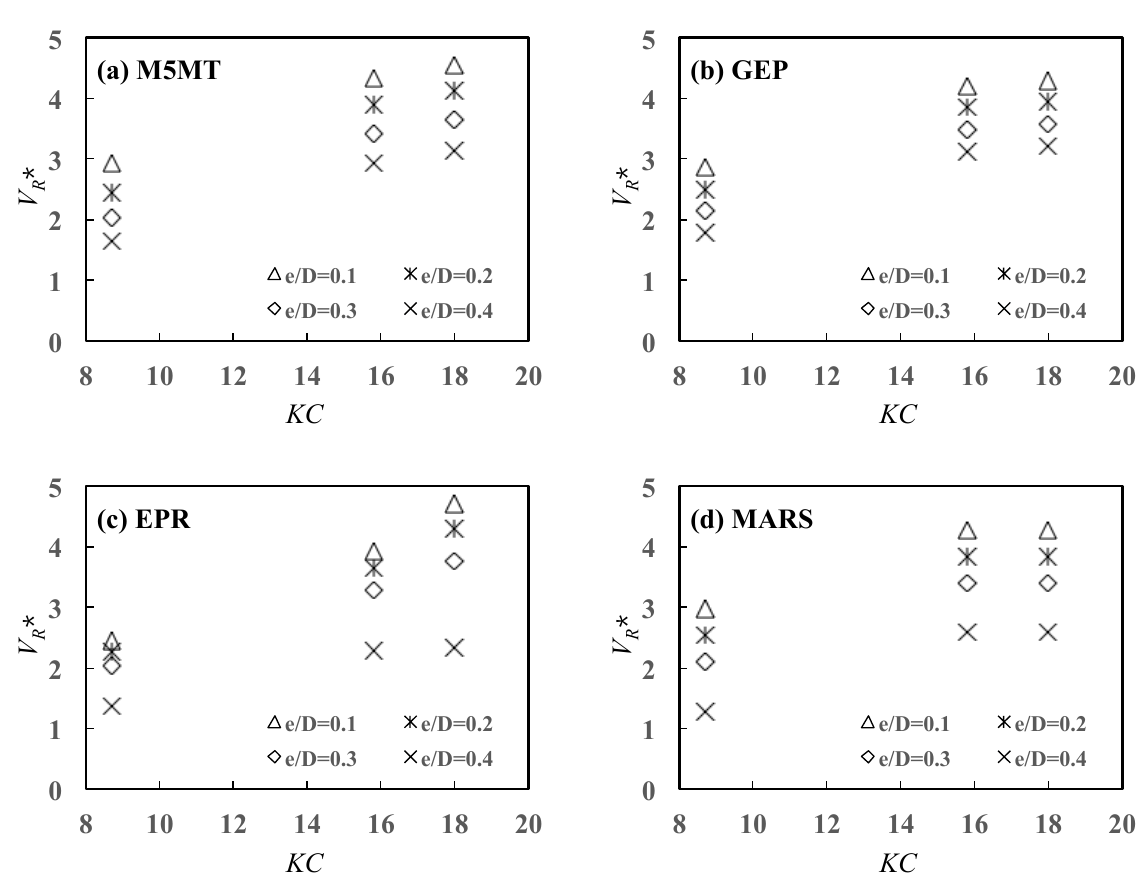
Table 6. SSE values for the considered AI models when predicting 𝑉 𝑅∗ at various 𝑒 𝐷⁄ ratios and 𝐾𝐶 values.